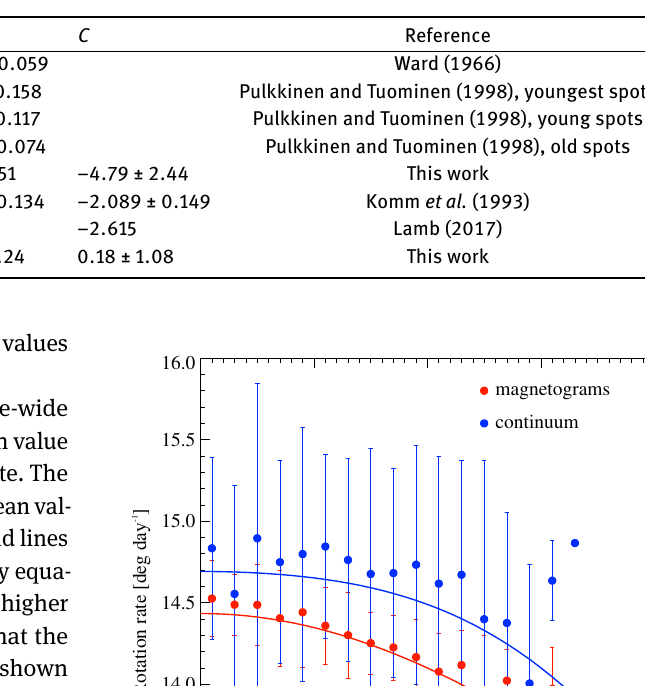
Figure 3. Colored solid lines show the best fitting of ω ci (blue) and ω m versus ϕ (red) relationships by equation 1. Filled sid circles are mean values of the derived rotation rates of the tracers located within 2-degree-wide latitudinal bins. The error bars rep- resent the standard deviation of the tracer rotation rate within the latitudinal bins.